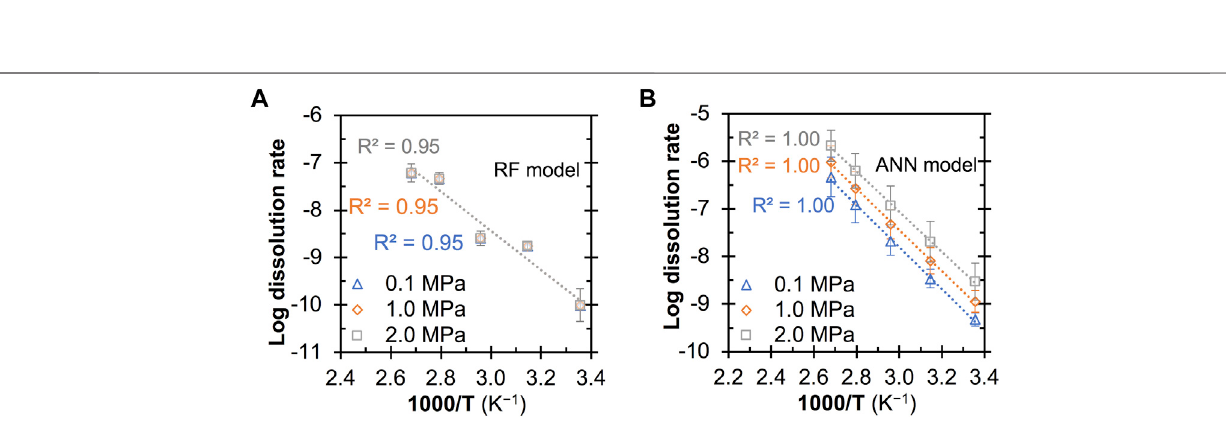
FIGURE 6 | Predicted quartz dissolution rate (in mole/m 2 /s) at 25 ° C and 0.1 MPa as a function of pH T and Na content from the (A) RF and (B) ANN models. The error bars represent one standard deviation for the predictions from twenty independently trained models.